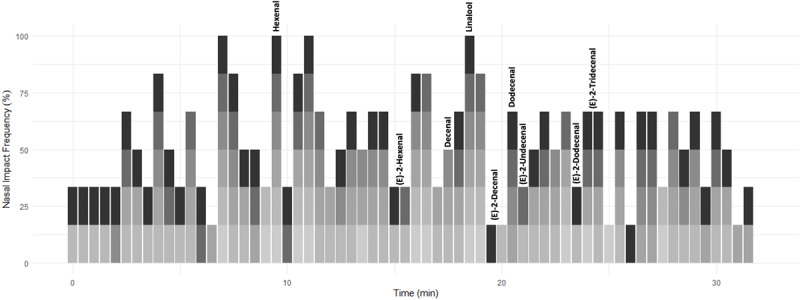
A time series depicting the time aromatic compounds were detected in commercially sold C. sativum by six panelists (denoted in shades of gray). The scent was assigned a score of 0 (no aroma detected) to 1 (aroma detected) over a period of 32 min and then converted to%. This annotated time series was compared to the GC-MS chromatogram of supermarket-purchased C. sativum. Aromatic compounds of interest are annotated.